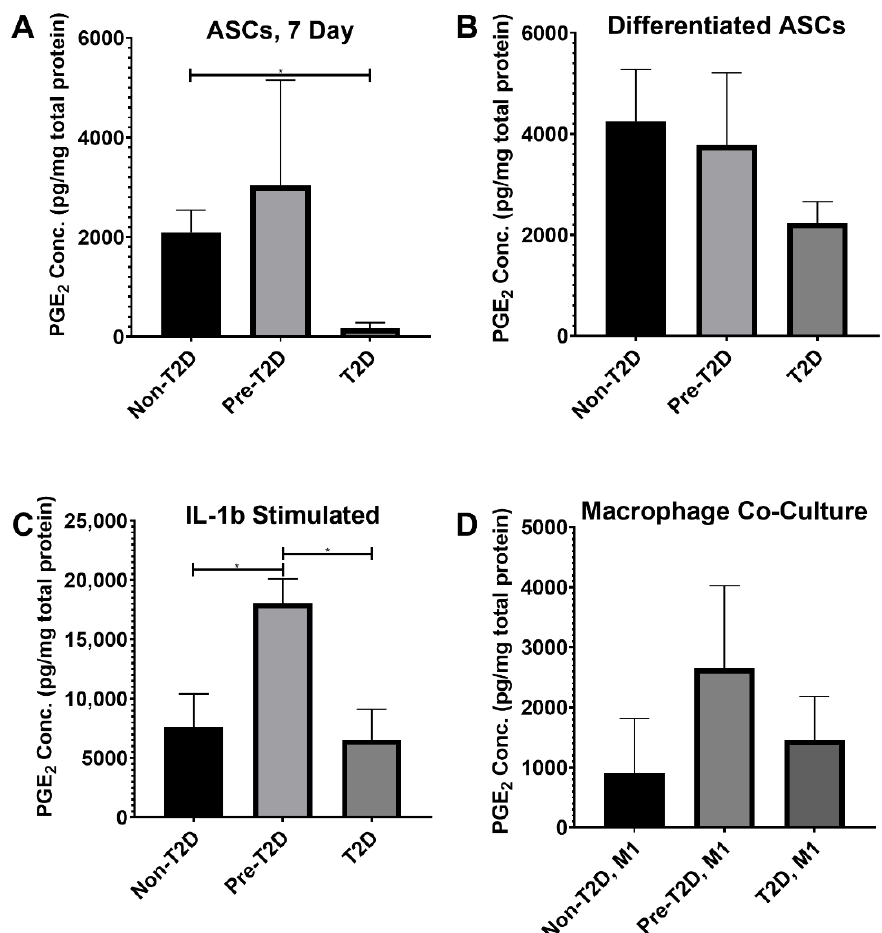
Figure 7. Increased PGE2 concentration in Pre-T2D IPFP-ASC conditioned media after induction with IL-1 β . ( A–D ) PGE2 Concentration as determined by ELISA per total protein content as determined by BCA ( n = 3, * p < 0.05). Non-T2D: Non-Type II diabetes mellitus, Pre-T2D: Pre-Type II